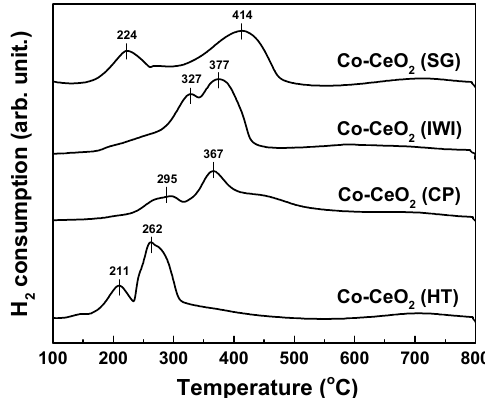
Figure 4. H 2 -temperature programmed reduction (H 2 -TPR) profiles of Co–CeO 2 catalysts prepared by different synthetic methods.